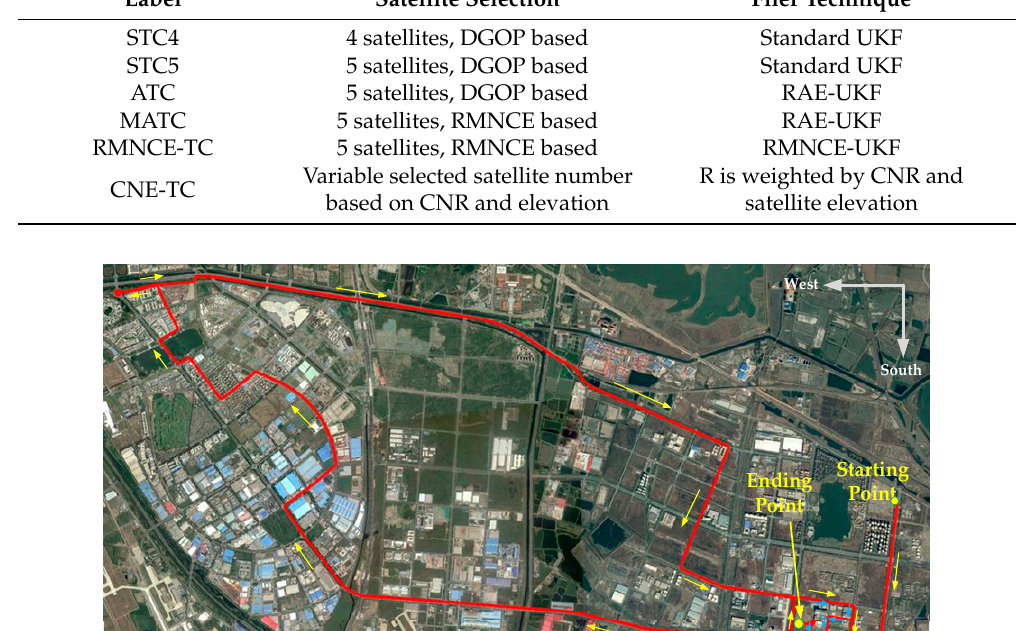
Figure 10. The test vehicle platform and equipment. ( a ) Designed hardware platform; ( b ) GNSS antennas and the NovAtel device. Table 7. Different schemes during the test.